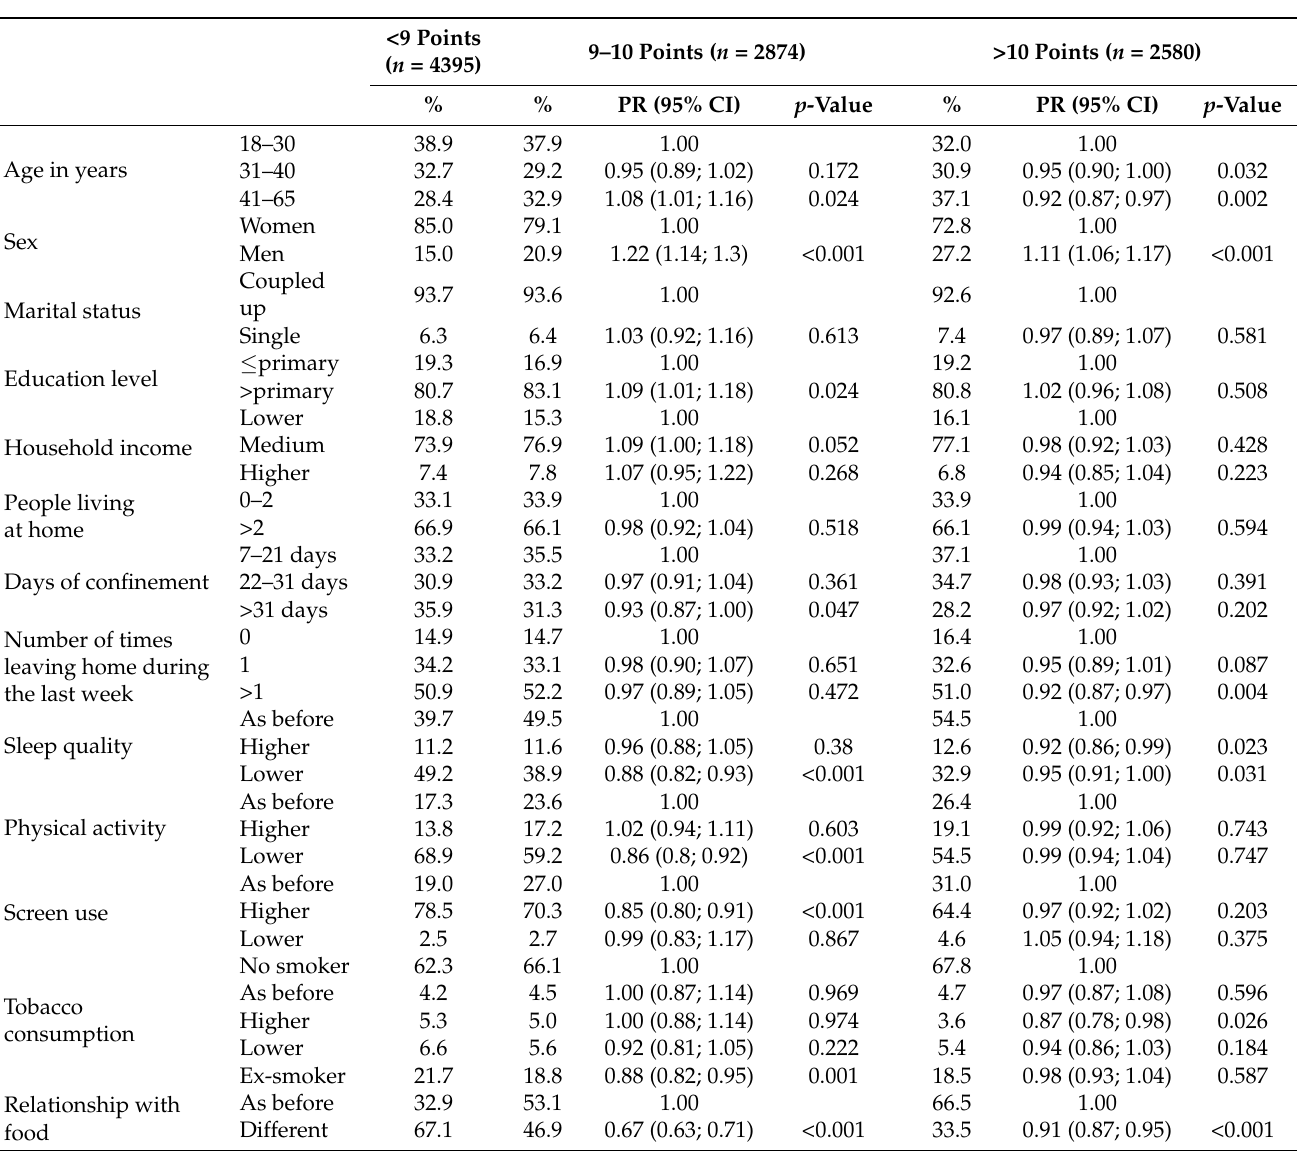
Table 3. Associated factors with medium (9–10 points) and high (>10 points) scores of emotional eating in the participants in the CoV-Eat project ( n =